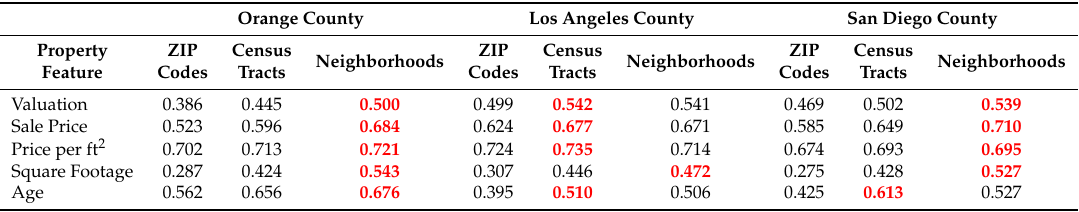
Table A2. Adjusted R squared value for each tabulation criteria across 3 counties (higher is better). Highest values per property feature are highlighted in